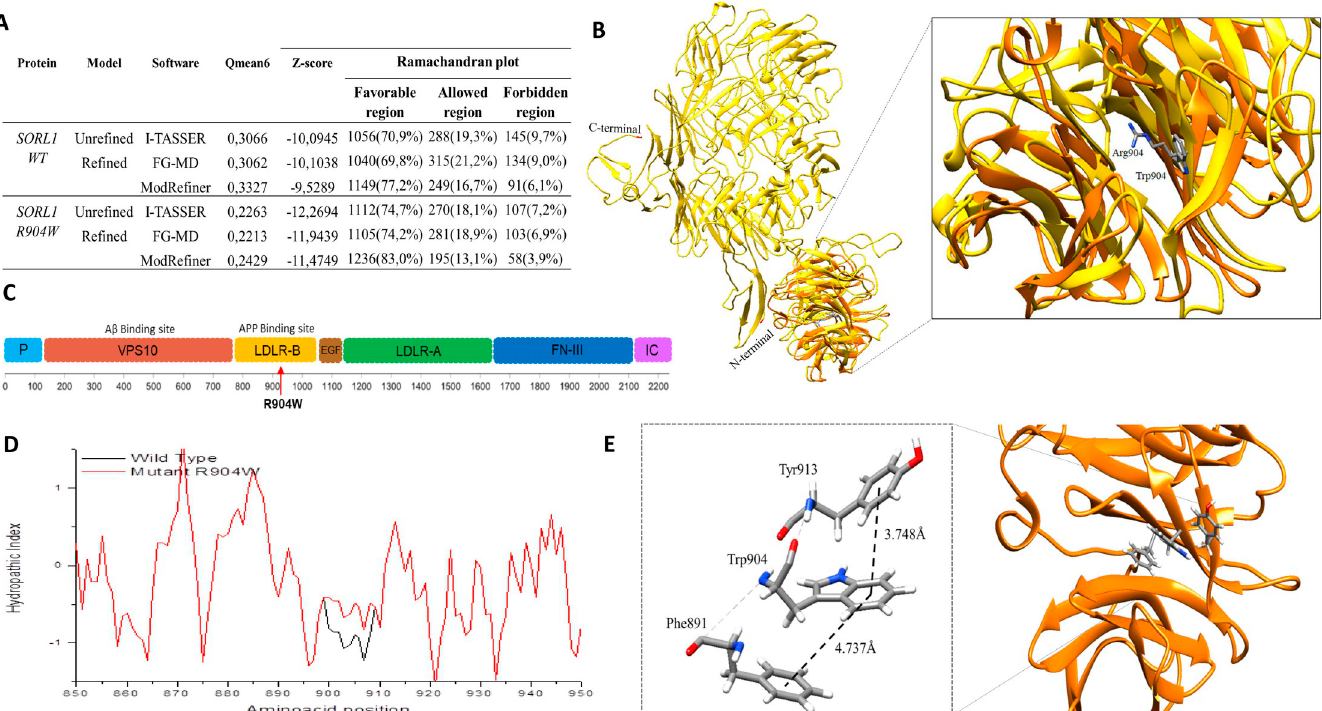
Fig 3. SORL1 structural model. A. Energy and stereochemistry validation of structural models of SORL1 protein. B . Structural model of SORL1 protein with UCSF Chimera software and detail of amino acid change R904W of the SORL1 protein. C . Domains of SORL1 protein. Modified from E. Louwersheimer et al. P: Pro-peptide. VPS10: Vacuolar protein sorting domain 10. LDLR-B: LDL-receptor class B repeats. EGF: Epidermal growth factor precursor type repeat. LDLR-A: LDL-receptor class A repeats. FN-III: Fibronectin type-III repeats. IC: Intracellular component. LDL: Low density lipoprotein. D . Hydropathic index. Black: Wild type, Arginine at position 904 of the SORL1 protein. Red.: R904W, Tryptophan at position 904 of the SORL1 protein. E . Co-planarity interaction of the amino acids Phe (phenylalanine 92) -Trp (Tryptophan 105) -Tyr (Tyrosine 114).